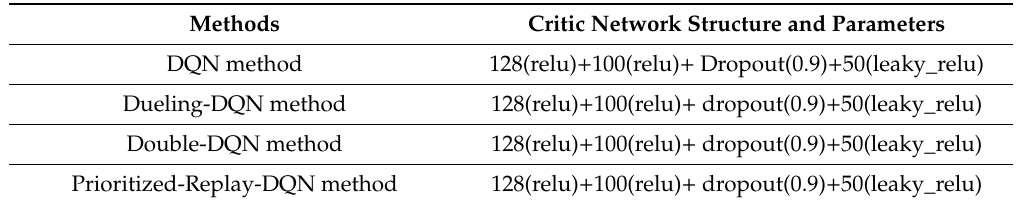
Table A2. Network structure and parameters of four DQN-based